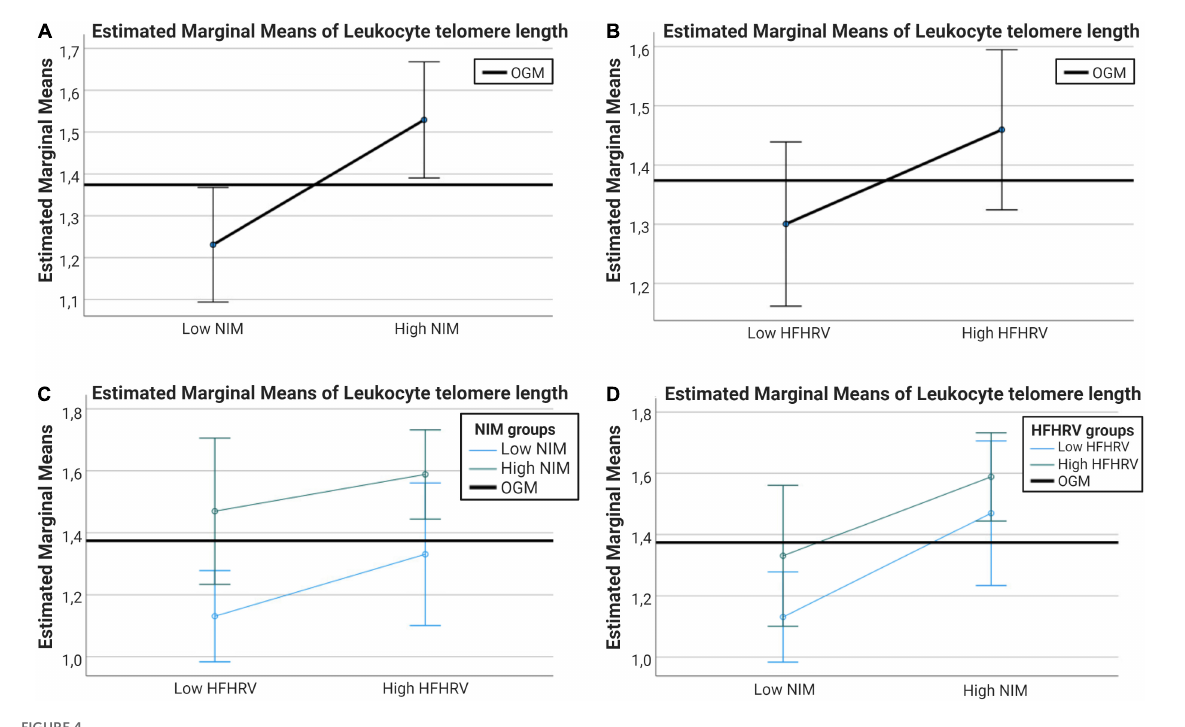
FIGURE4 Interval plots showing the differences in telomere length between NIM index groups and between HFHRV groups. (A) Interval plots for differences in LTL between high and low NIM index groups. (B) Interval plots for differences in LTL between high and low HFHRV groups. (C) Interval plots plotting differences in LTL between high and low HFHRV groups according to NIM index group. (D) Interval plots plotting differences in LTL between high and low NIM index groups according to HFHRV groups. Error bars are 95% confidence intervals. Covariates appearing in the models are evaluated at the following values: WBC = 0.7704. OGM, observed grand mean; WBC, white blood cell count; NIM, vagal neuroimmunomodulation index; HFHRV, high frequency component heart rate